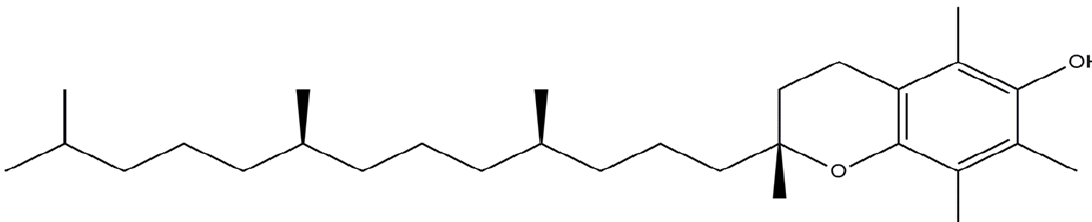
Figure 1. Molecular structure of α